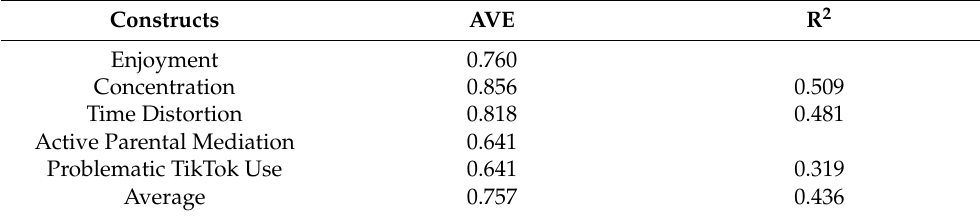
Table 9. Summary of AVE (Average Variance Extracted) and R 2